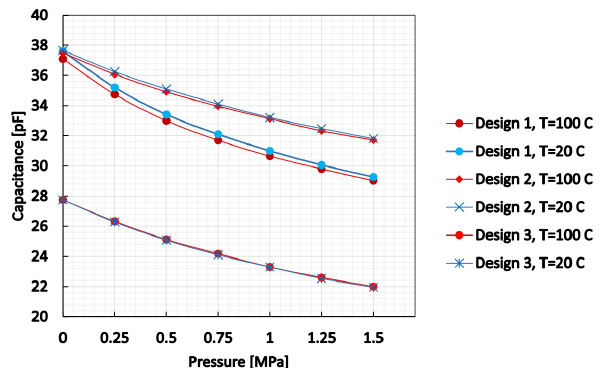
Figure 17. A quarter of the elliptical diaphragm displacement in design 2 using FEA.